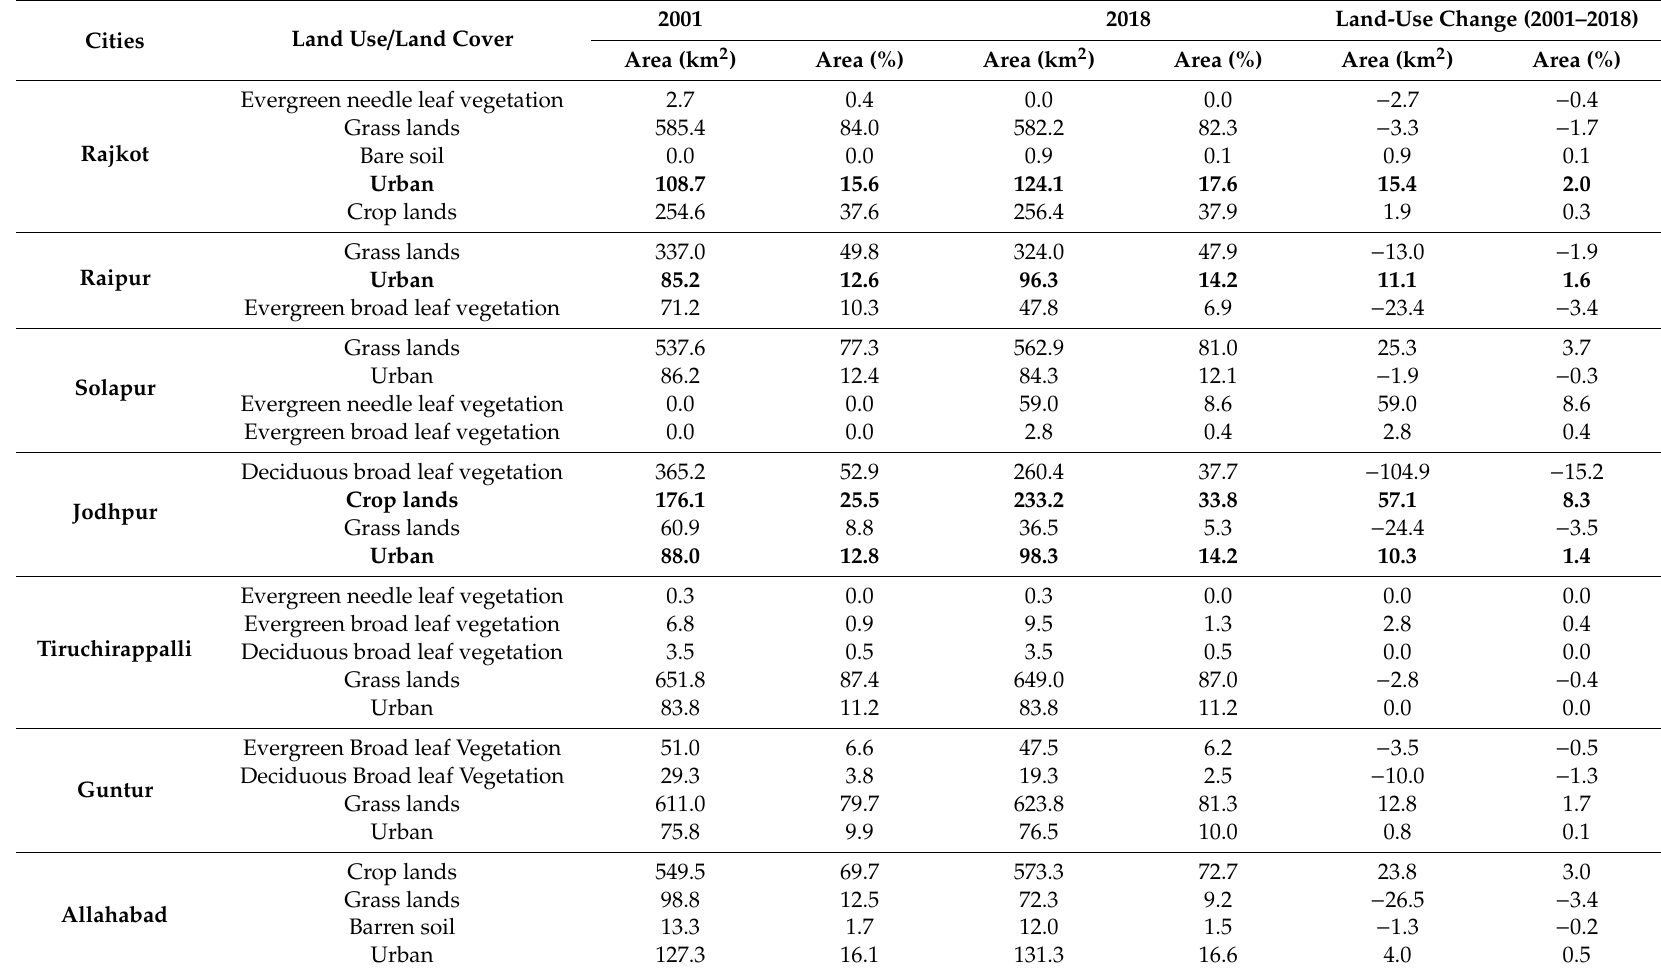
Table 3. Land use / land cover changes between 2001 and 2018 in the selected cities.